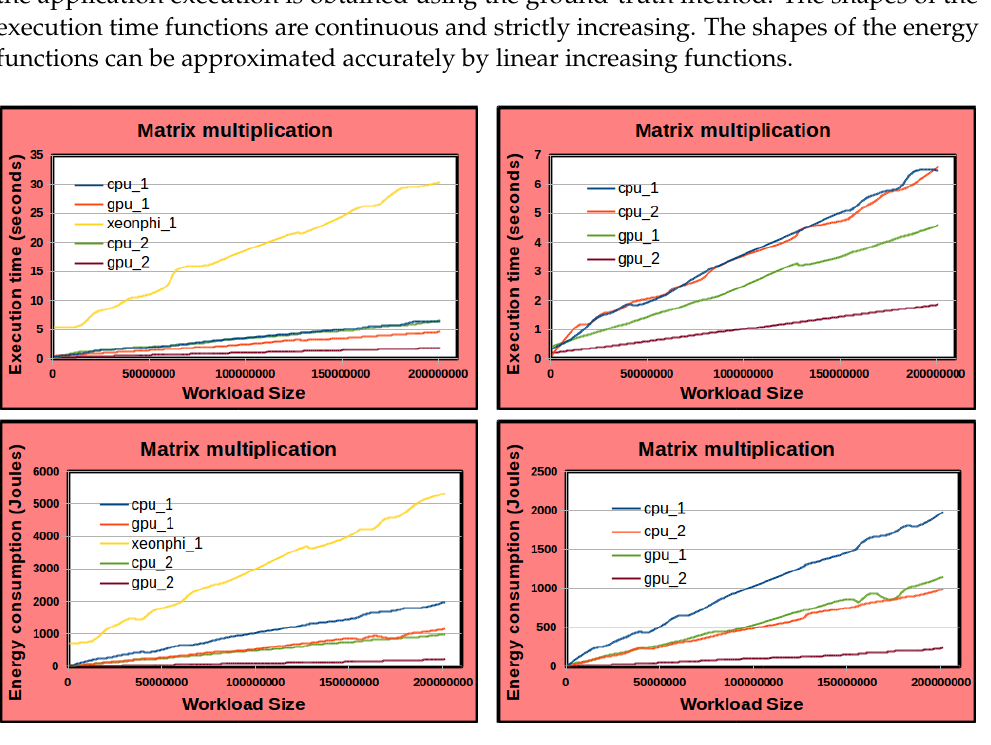
Figure A1. The figures in the left column show the execution time and energy profiles of the five heterogeneous processors (Figure 1) employed in the matrix multiplication application. The figures in the right column exclude the Xeon Phi profiles since its energy profile dominates the other energy profiles. Note that the execution time profiles of CPU_1 and CPU_2 are close to each other. However, the energy profile of CPU_1 is significantly higher than that of